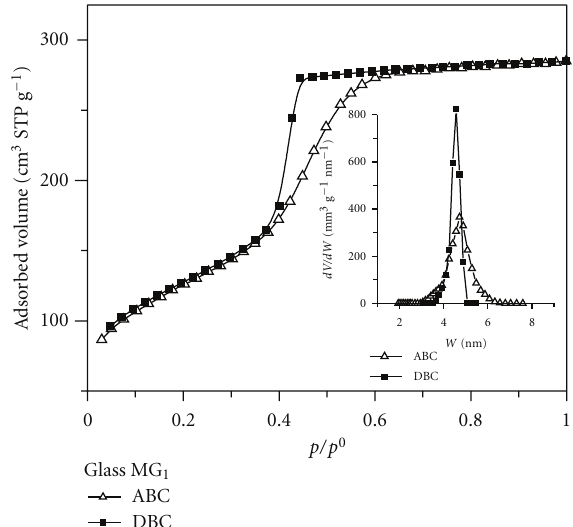
Figure 8: N 2 sorption on (a) MG 1 undoped.